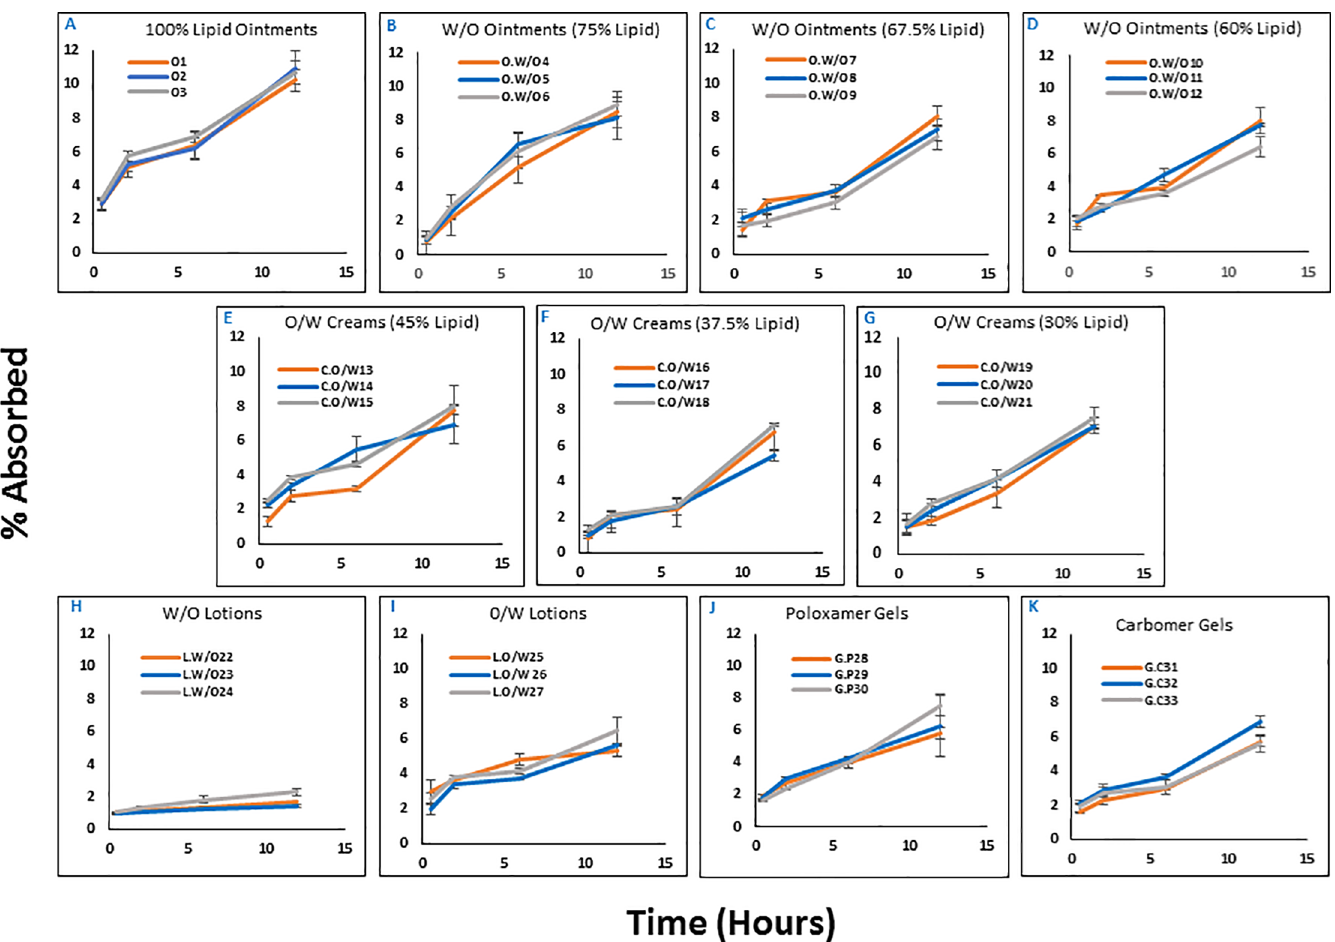
Fig 2. Transdermal absorption. The ex-vivo transdermal absorption profile through pig skin for the entire formulation library. Each panel represent a set of three formulations that shared similar phase composition and lipid content, but differed in surfactant system (n = 3; error bars indicate standard deviation).